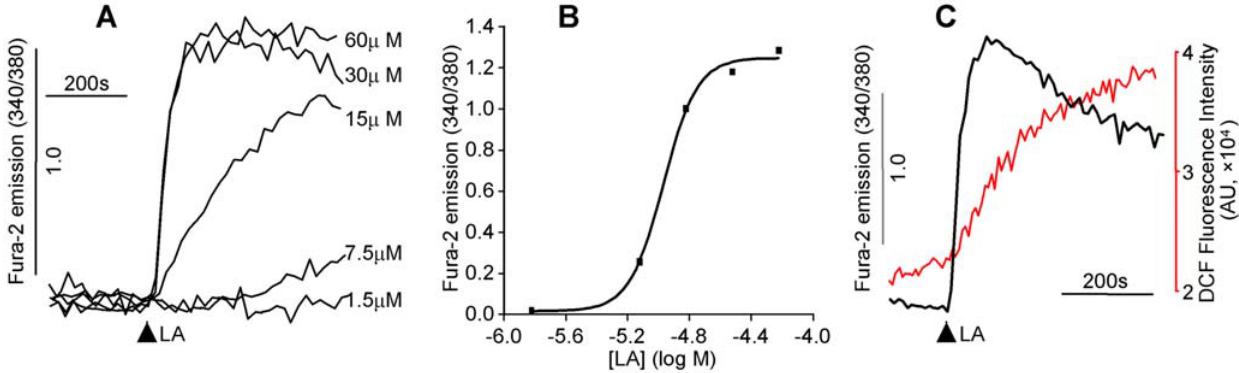
Figure 1. LA-induced [Ca 2 + ] i mobilization and ROS generation. Human mesangial cells were labeled with fura-2 (1 m M) alone or together with DCF (1 m M) (37 u C, 30 min). The fluorescent intensity in the figures was presented as arbitrary unit (AU). (A): Traces represent the [Ca 2 + ] i responses induced by different concentrations of LA. (B): The curve shows the relationship between the amplitude of [Ca 2 + ] i responses and the LA concentrations. (C): Traces represent LA (30 m M)-induced [Ca 2 + ] i mobilization (black trace) and the associated ROS generation (red